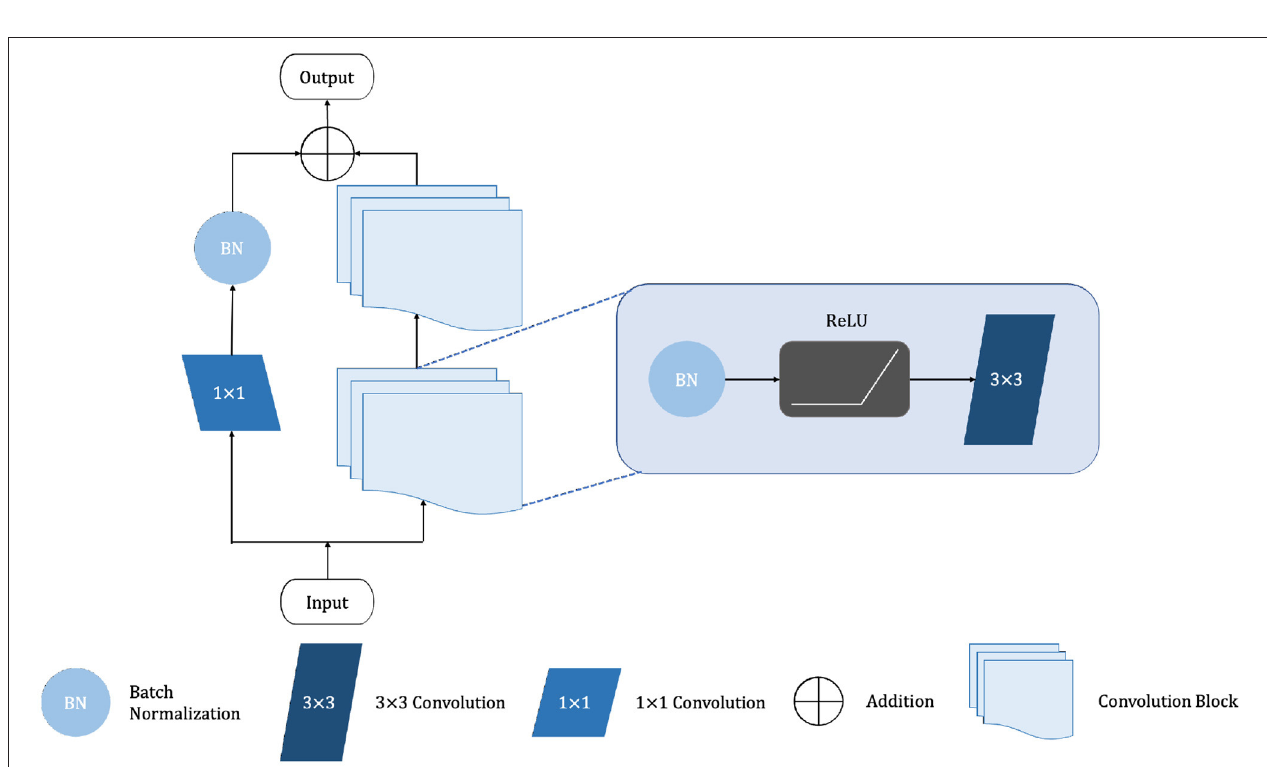
FIGURE 3 | The framework of residual